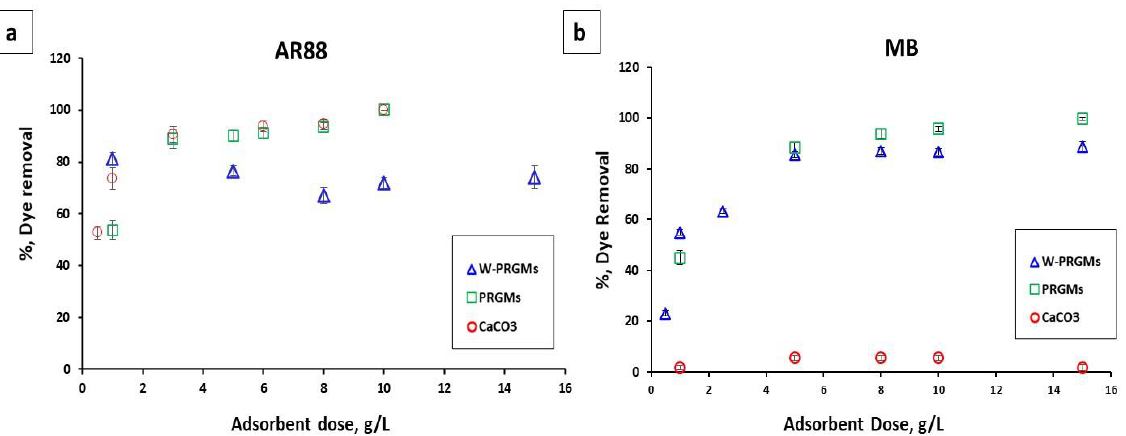
Figure 3. The influence of the PRGMs loading on the adsorption of ( a ) AR88 and ( b ) MB after equilibrium (C 0 = 200 mg/L for AR88 and 25 mg/L for MB, pH = 2.5 for AR88, pH = 10 for MB; dye volume = 10 mL; T = 22 ± 2 °C).